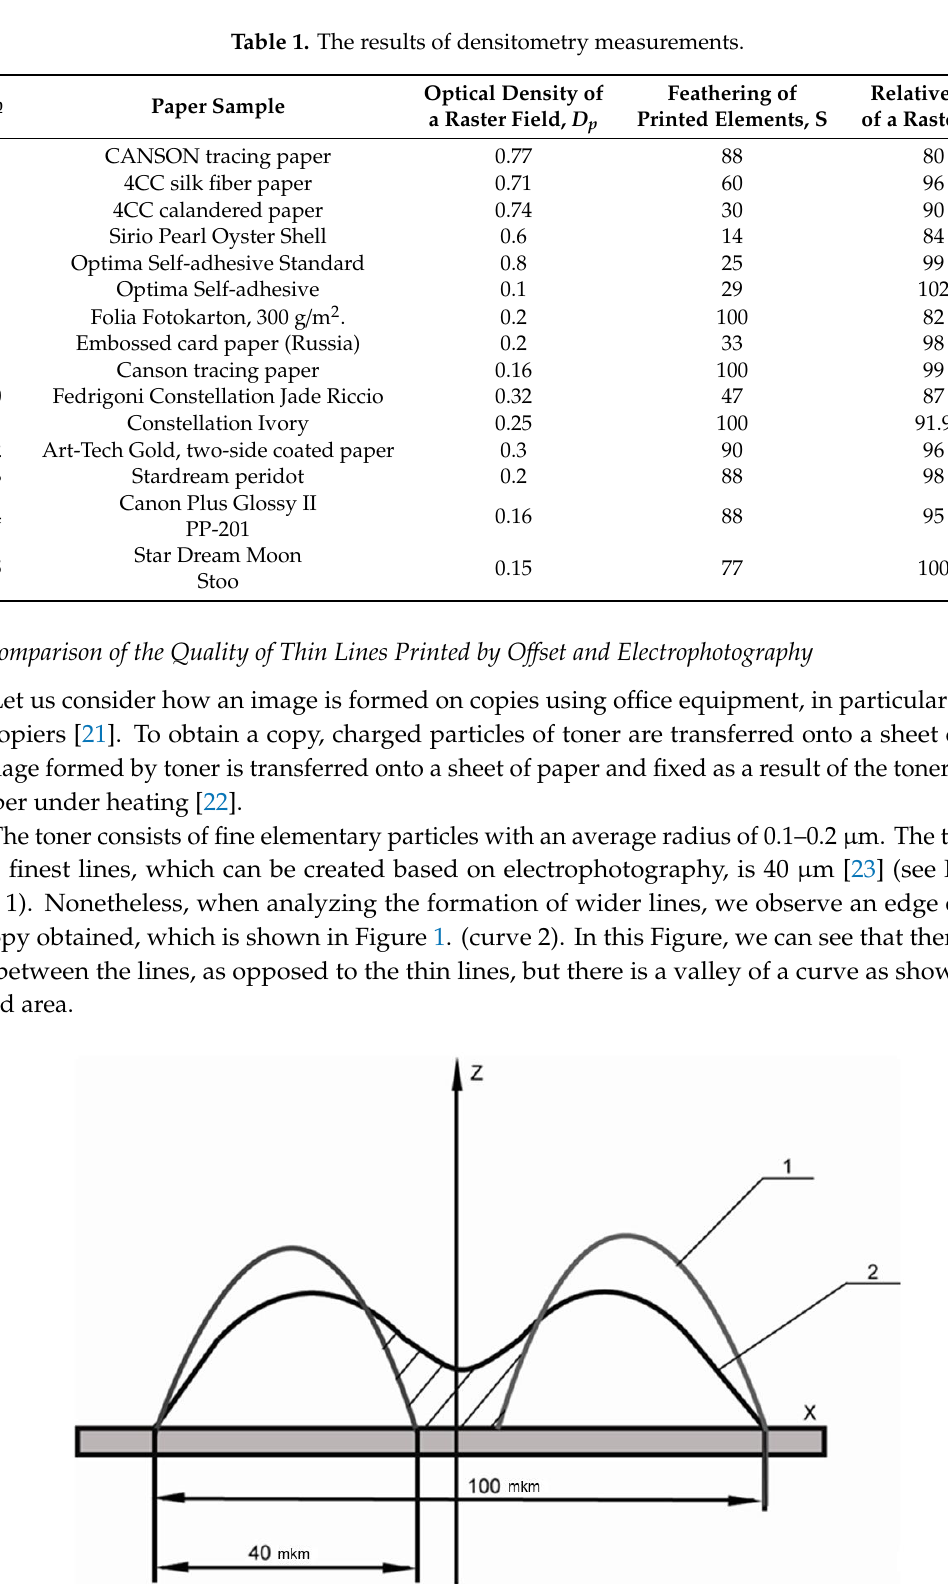
Figure 1. Distribution of toner’s particles in making a copy on a copy machine, where Z represents the number of toner’s particles, X stands for (current value) thickness of the line.